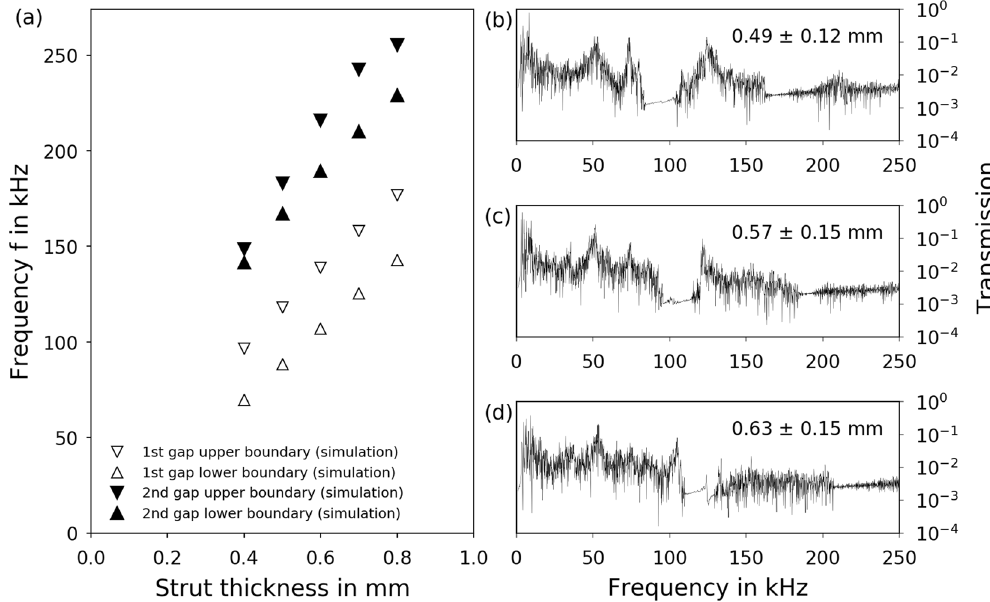
Figure 4. Size and position of the first and second phononic band gap in dependency of the strut thickness. ( a ) Numerical results (l = 5.0 mm, A = 1.0 mm). Experimentally obtained transmission spectra for (100) direction samples built with a line energy E L of ( b ) 0.4 J/mm, ( c ) 0.6 J/mm and ( d ) 0.8 J/mm with corresponding strut thickness as measured in